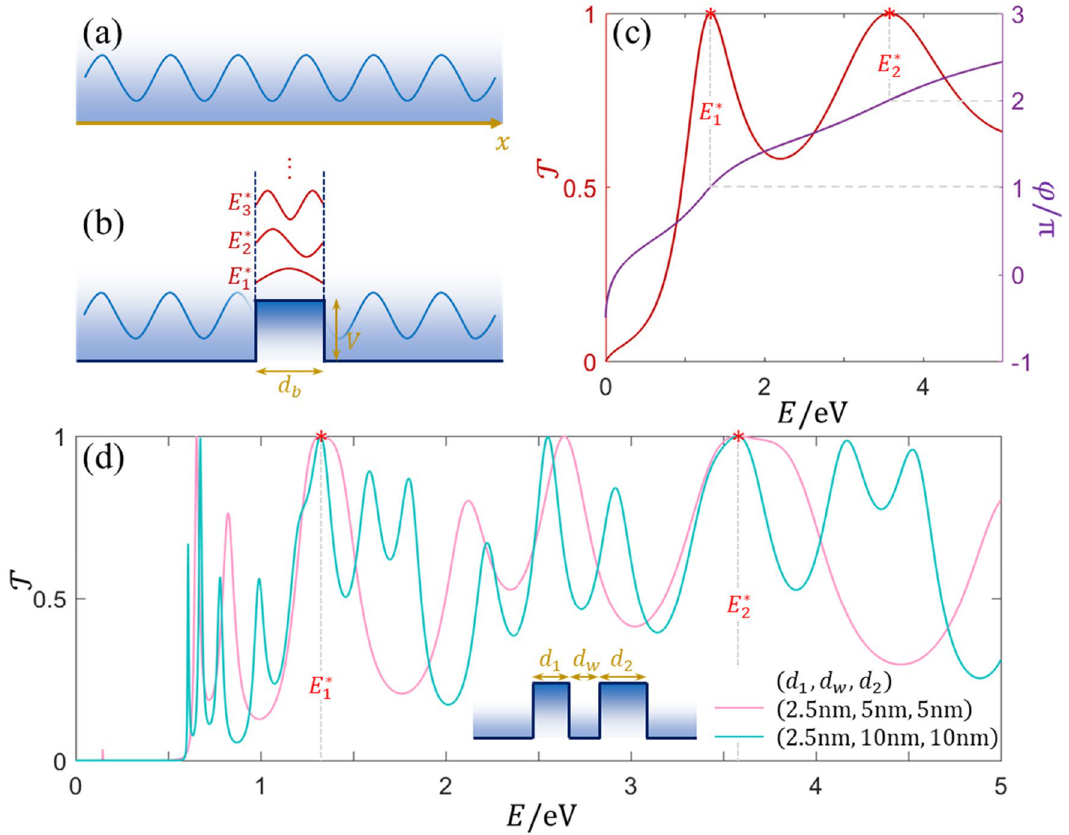
Figure 1. ( a ) Electronic wave travels in a uniform conductor. ( b ) Electron transmission through a single- barrier with the barrier height V and barrier width d b , the electronic wave at energy of E ∗ n denotes the n th resonant mode, whose PS is n π . ( c ) The transmission spectrum and PS of the InP single-barrier when d b nm, peaks at E ∗ 1 and E ∗ 2 correspond to the resonant modes. ( d ) The transmission probability of the InP/InAs/InP double-barrier with different widths. Inset is the potential profile of the asymmetric double-barrier